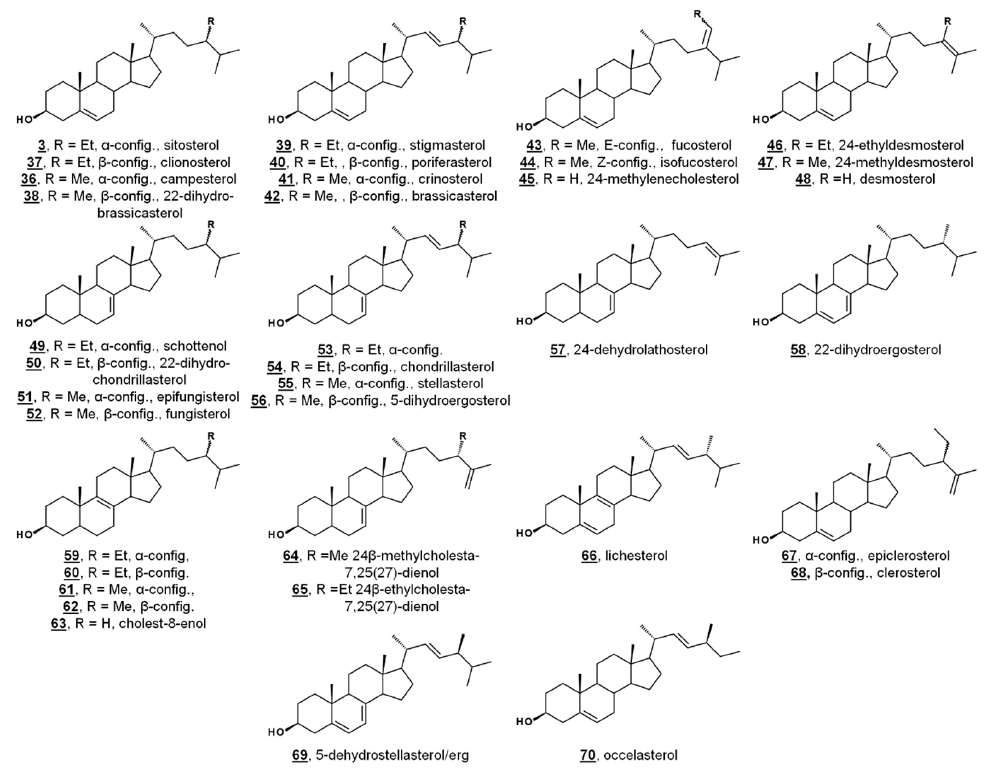
Figure 4. Molecular structures of algal sterols. Table 1. Recently reported sterol profiles from algae across classes.